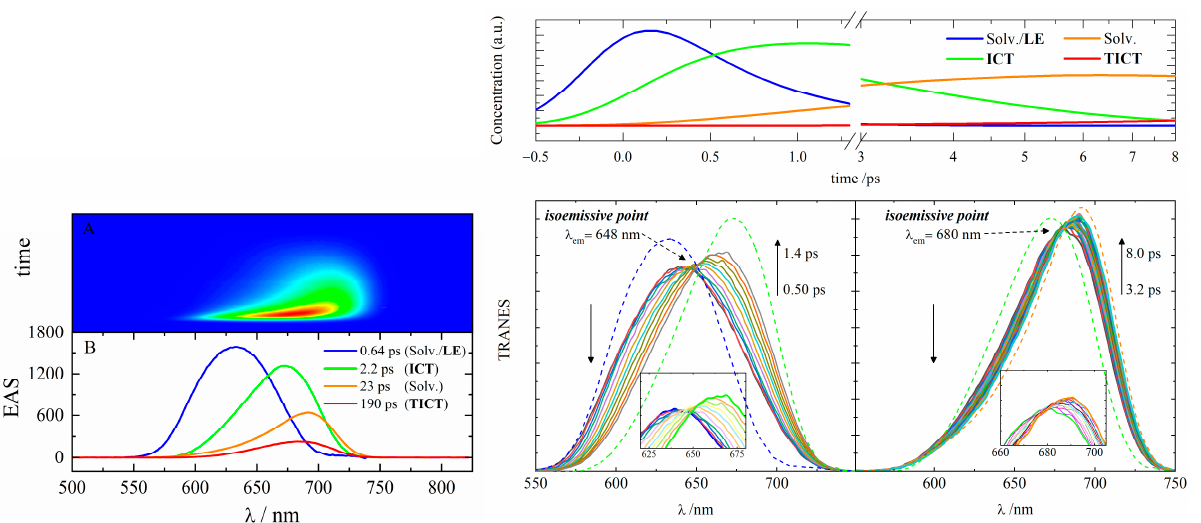
Figure 3. Femtosecond fluorescence up-conversion (fs-FUC) measurement of compound pPy- π 2 in MeOH obtained by pump-probe experiment ( λ exc = 400 nm, left ): panel A, experimental 3D matrix reporting color-coded Δ A as a function of wavelength and time ( Δ A = 0 blue, Δ A > 0 increasing from green to red); panel B, EAS obtained by Global Analysis. Time-resolved area-normalized emission spectra (TRANES) analysis ( right ): upper panel, concentration profiles for the transient species detected by Global Analysis; lower panels, TRANES evolution over time calculated in proper delay time intervals together with the EAS obtained by Global Analysis (dashed lines) reported as limit spectra.